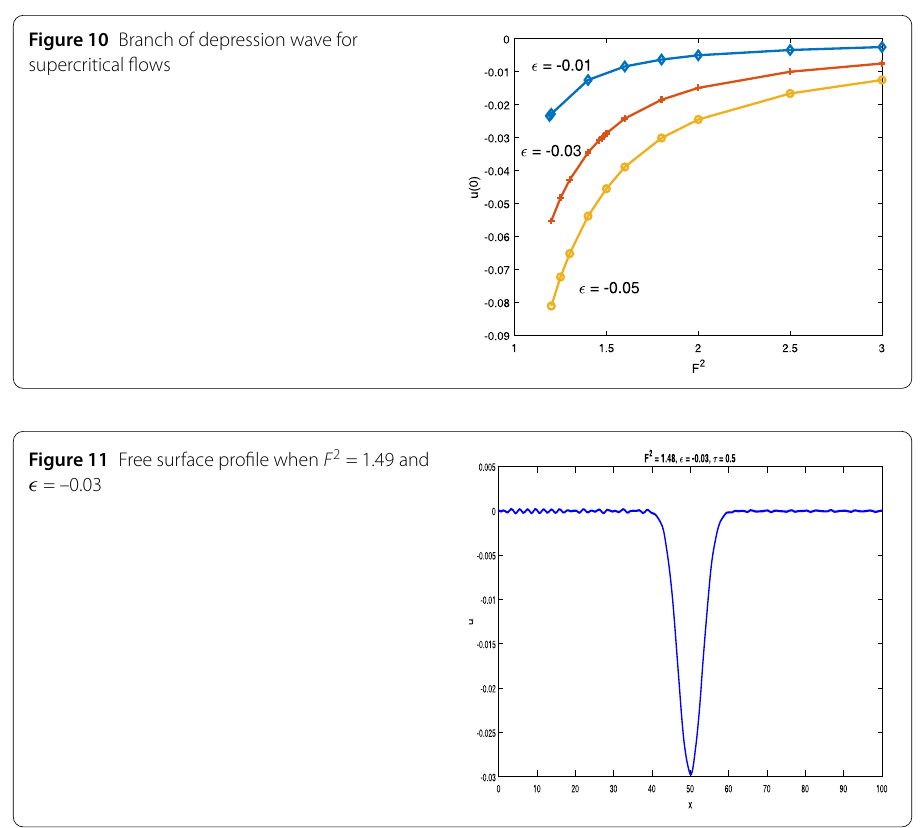
Fig. 10. The free surface profile when (cid:7) = –0.03 and F 2 = 1.48 is shown in Fig. 11. The generalized depression wave with ripples is found when the Froude number approaches a critical value. For (cid:7) = –0.03, the critical value of F is approximately 1.47. All numerical solutions are bifurcated from the uniform flow